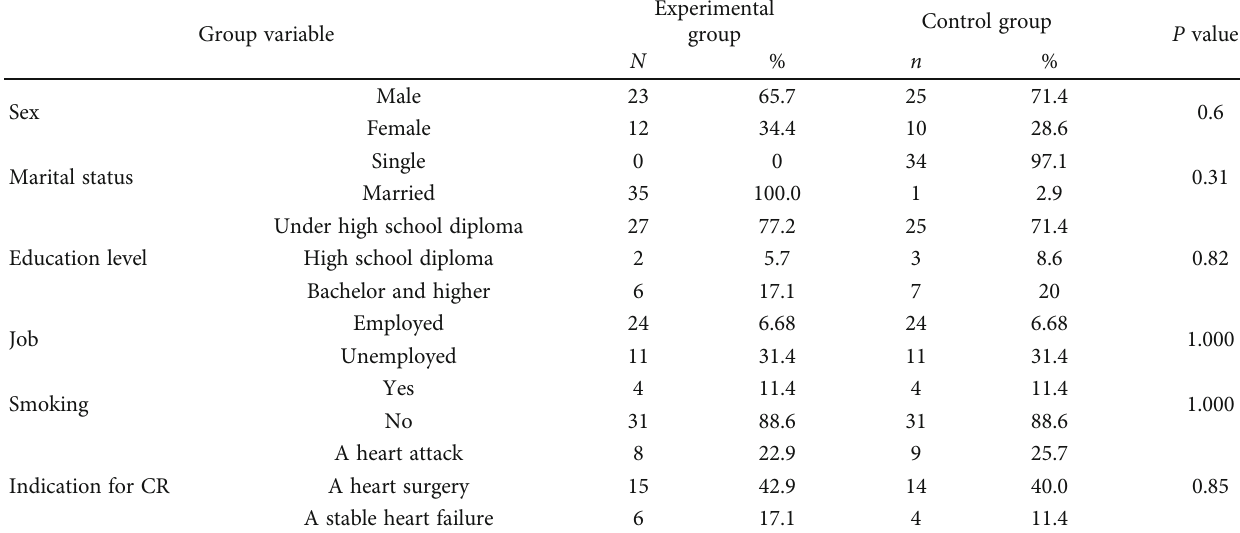
Table 1: Demographic characteristics of the participants.